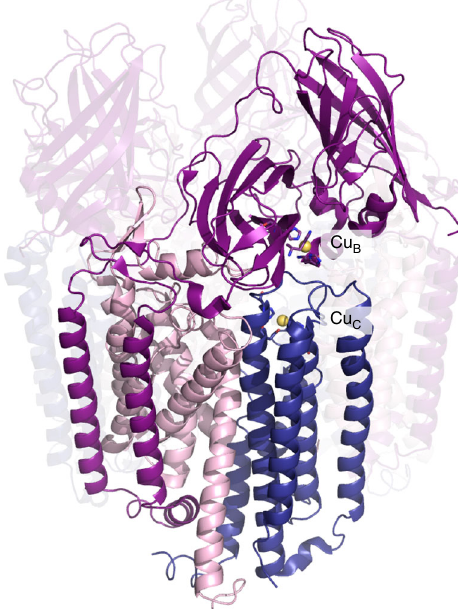
Fig. 1 The pMMO structure and location of the metal centers. In the crystal structure of Methylocystis sp. strain Rockwell-pMMO (4PHZ), there is a monocopper center in PmoB coordinated by residues His 29, His 133, and His 135 (Cu B ), and a monocopper center in PmoC coordinated by Asp 129, His 133, and His 146 (Cu C ). PmoA, PmoB, and PmoC are shown in pink, purple, and blue, respectively, with one of the three protomers highlighted. Copper ions are shown as yellow